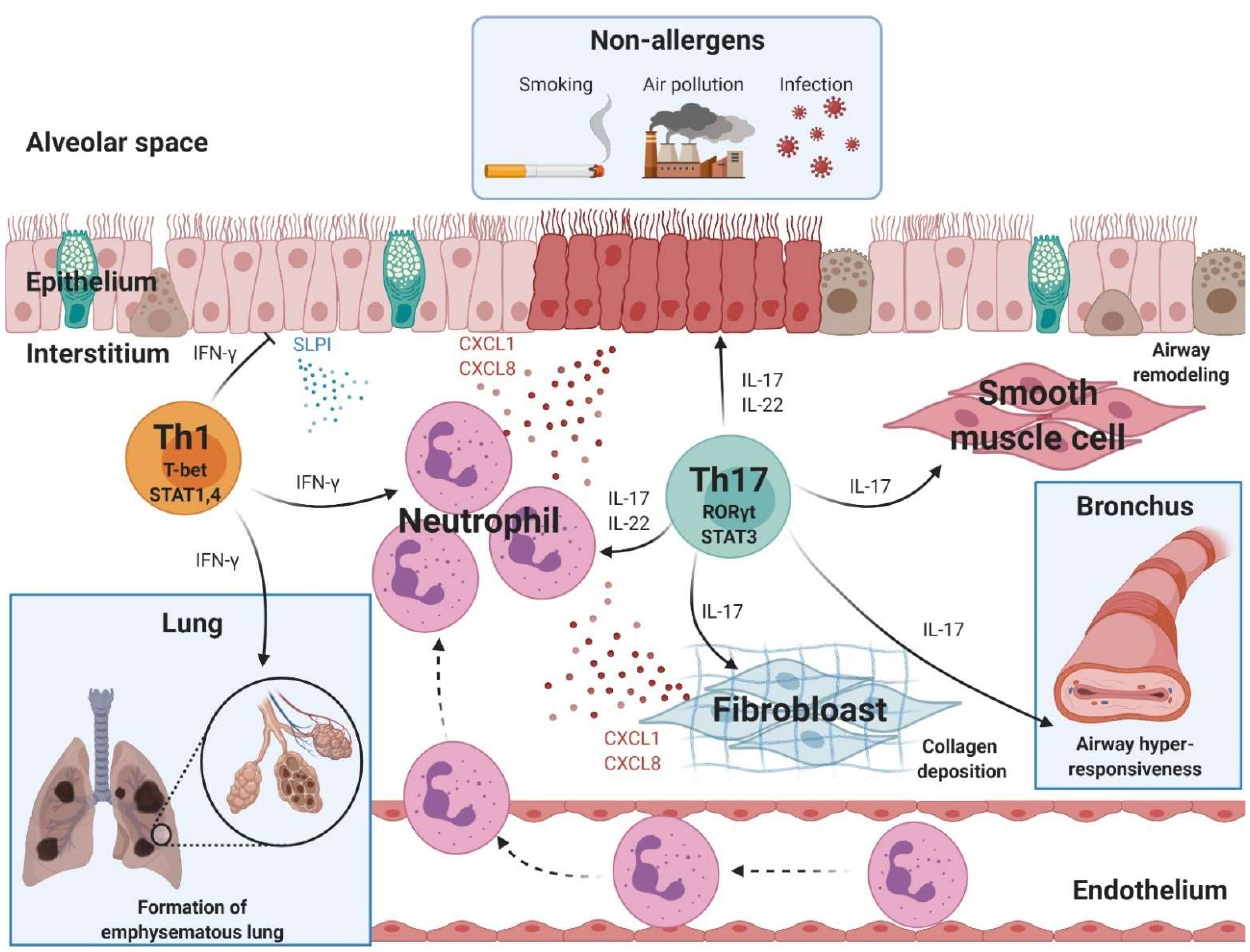
Figure 2. Pathogenesis of neutrophilic asthma mediated by Th1 and Th17 cells. The development of neutrophilic asthma is associated with subtypes of CD4 + T cells including Th1 and Th17 cells. Th1 cells are involved in mediating the infiltration of neutrophils and the formation of emphysematous lung. T-bet, STAT1, and STAT4 are transcriptional factors in Th1 cells. Th17 cells play critical roles in neutrophil infiltration, airway remodeling, collagen deposition, and airway hyperresponsiveness. RORγt and STAT3 are transcriptional factors in Th17 cells. Text color: Black, cytokine; Red, chemokine; Blue, anti-protease. T-bet, T-box protein expressed in T cells; RORγt, RAR-related orphan receptor gamma; CXCL, C-X-C motif chemokine ligand; SLPI, secretory leukocyte peptidase inhibitor. The figure was created using BioRender.com (accessed on 6 September 2021).